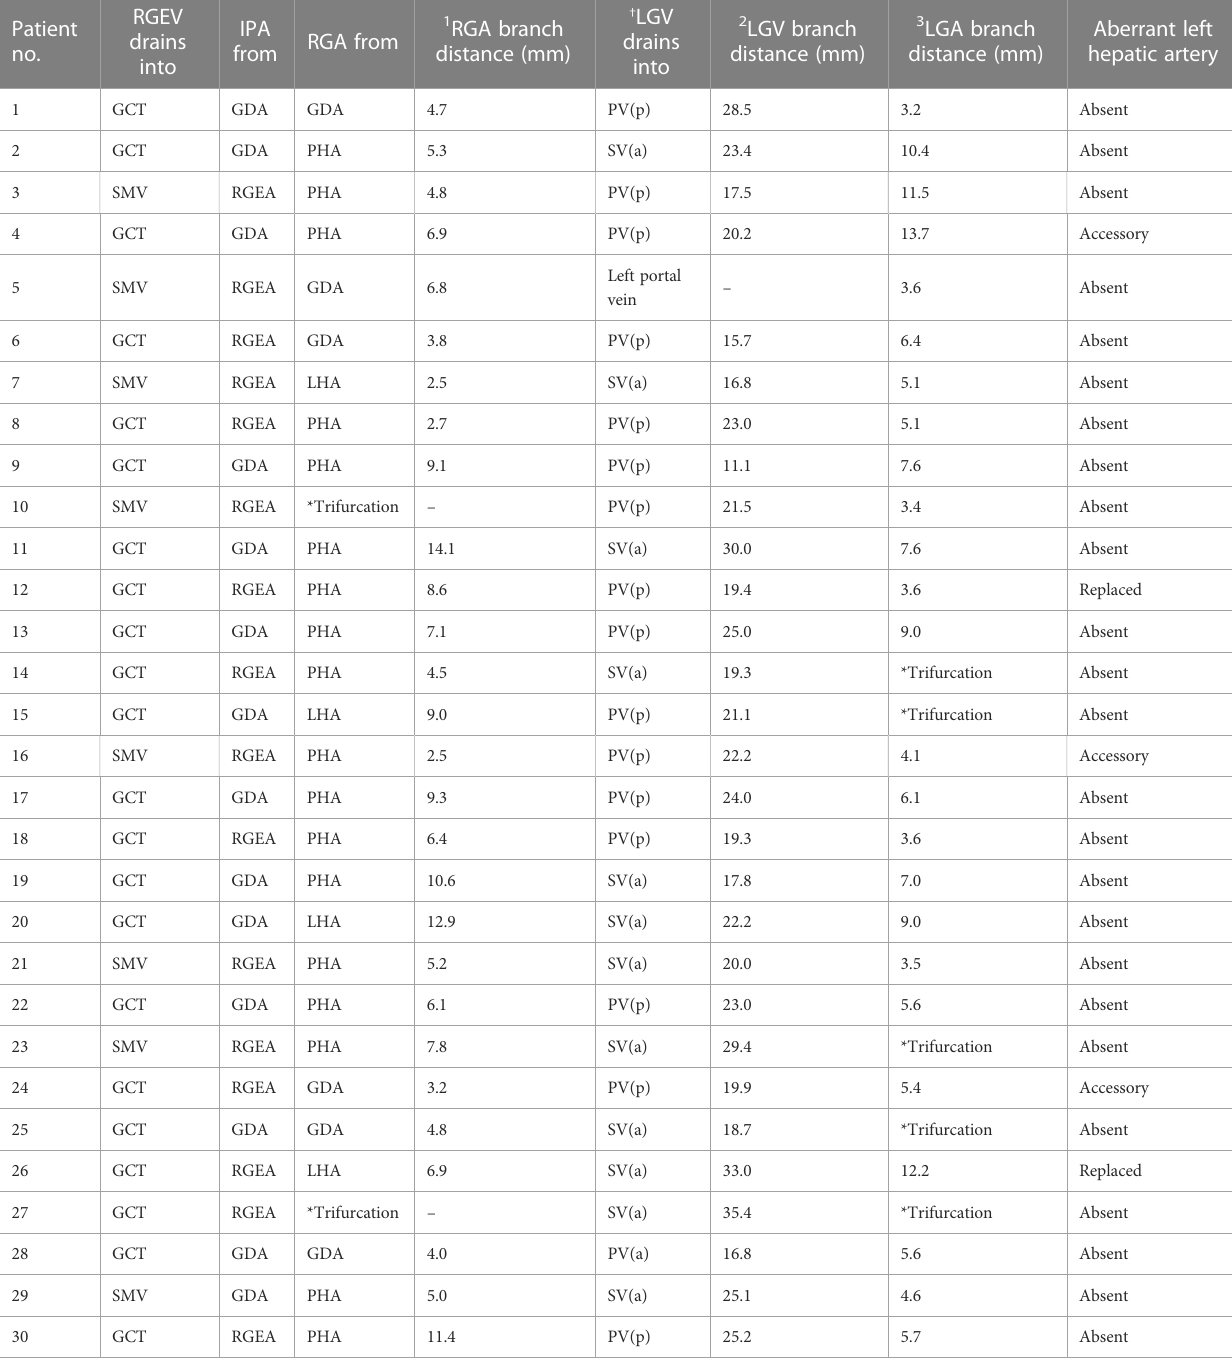
TABLE 2 Anatomic information of vessels of interest during robotic subtotal gastrectomy.